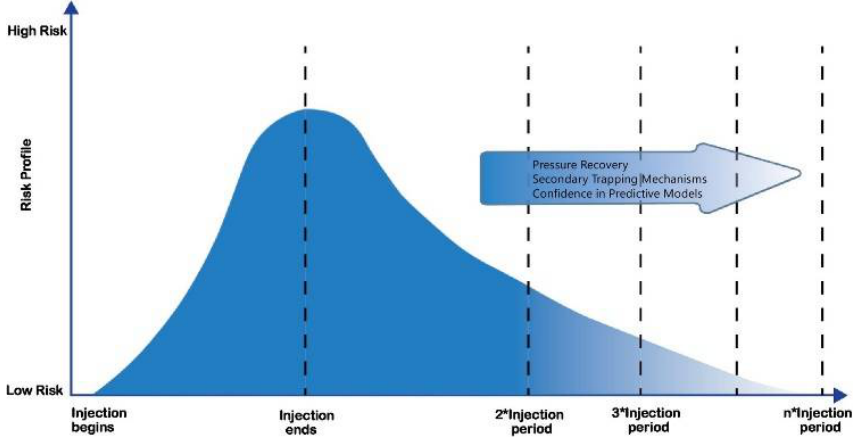
Figure 18. Conceptual risk profile of CO 2 storage in geological porous media. Reproduced with permission from [251], Elsevier, 2021.